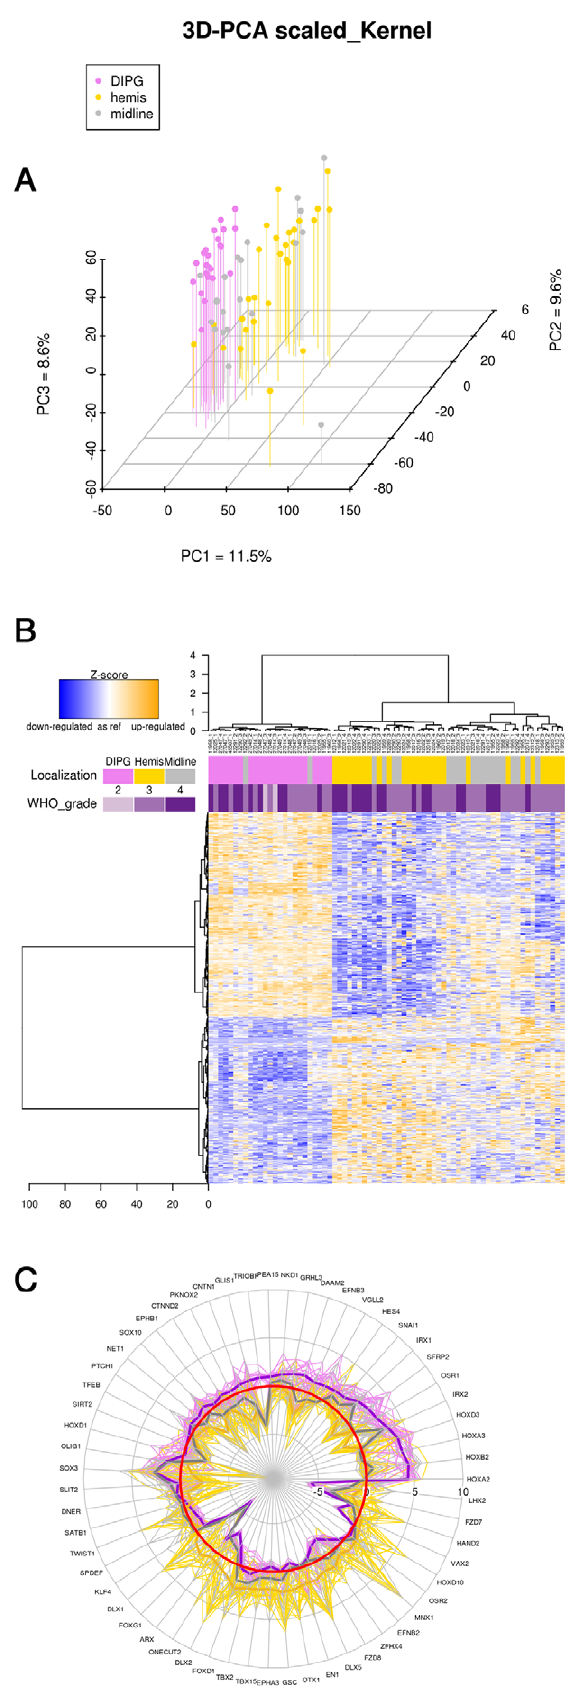
Figure 1. DIPG are different from supratentorial high-grade gliomas in children. Hemispheric, midline/thalamic tumors and DIPG are represented in gold, grey and violet respectively. Panel A: Gene expression of 23 DIPG and 49 supratentorial HGG were compared using a Principal Component Analysis on all 15231 quality control passing probes. Tumors are displayed according to their coordinates on the three first principal components, which describe 29.7% of the variance. Panel B: Heatmap of the 712 most differentially expressed genes between DIPG, midline and hemispheric tumors, selected using the moderated t-test of limma package of Bioconductor. Panel C: Radial plot of the expression of transcription factors and neurogenesis regulators according to the three tumor location, in log2 ratios related to normal brain stem. The zero red line represent the expression level of normal adult